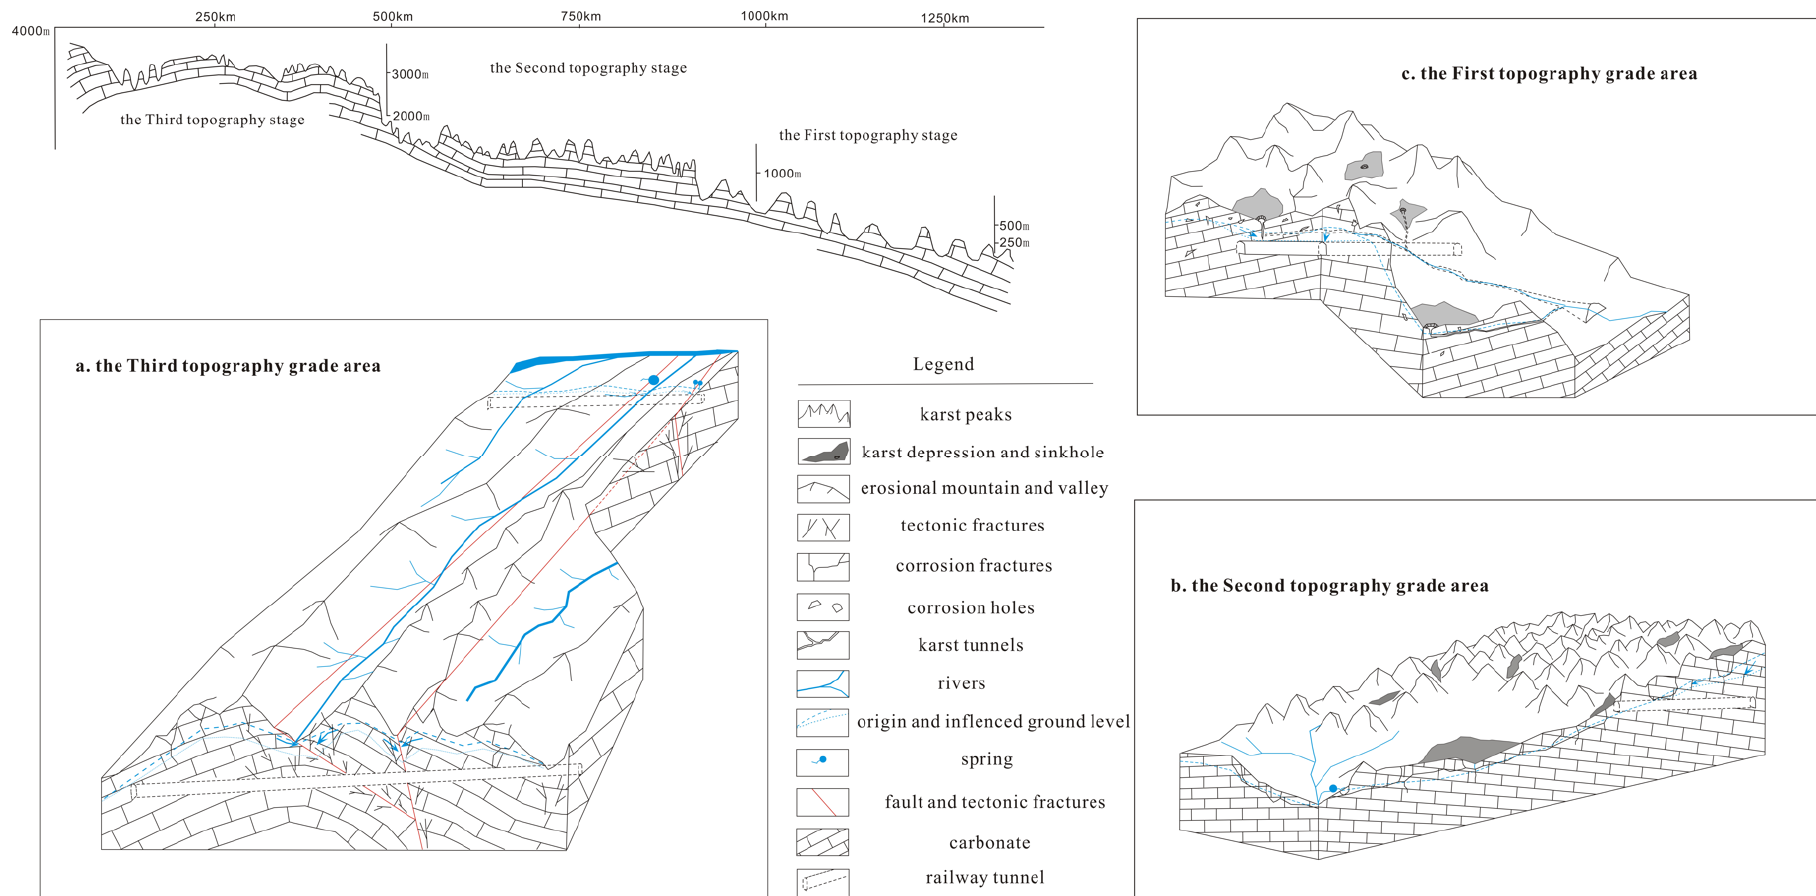
Figure 15. Influence pattern of tunnel excavation on groundwater environment of three topography stages in China.